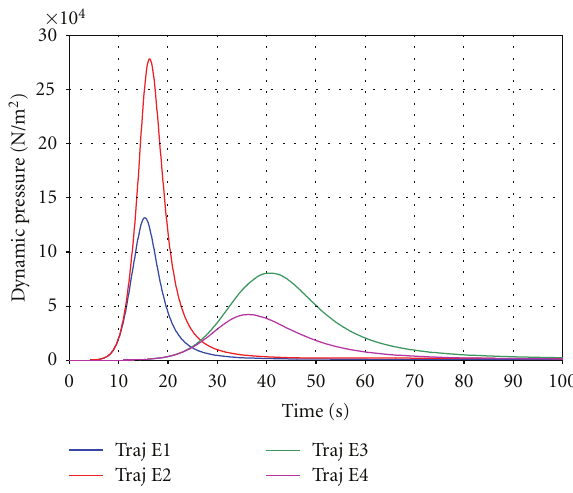
Figure 3: Stagnation Pressure for EVD mission